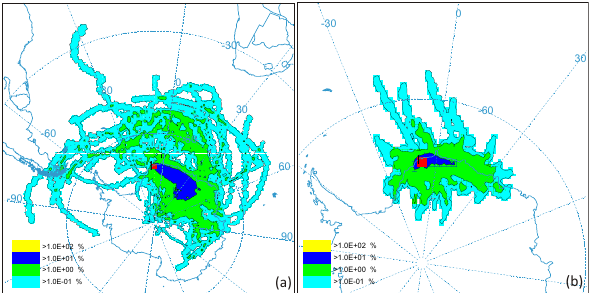
Fig. 7. Daily 10-day back trajectories for summer. Shown is the rel- ative (percentage) number of trajectory intersection on a given grid cell (resolution 1 ◦ × 1 ◦ ). The left-hand plot (a) presents all 10-day back trajectories for 222 Rn activity concentrations above 1SD of the mean (>0.043Bqm − 3 , N = 188), while on the right (b) the corre- sponding 10-day back trajectories for 222 Rn activity concentrations below 1SD of the mean (<0.013Bqm − 3 , N = 139) are